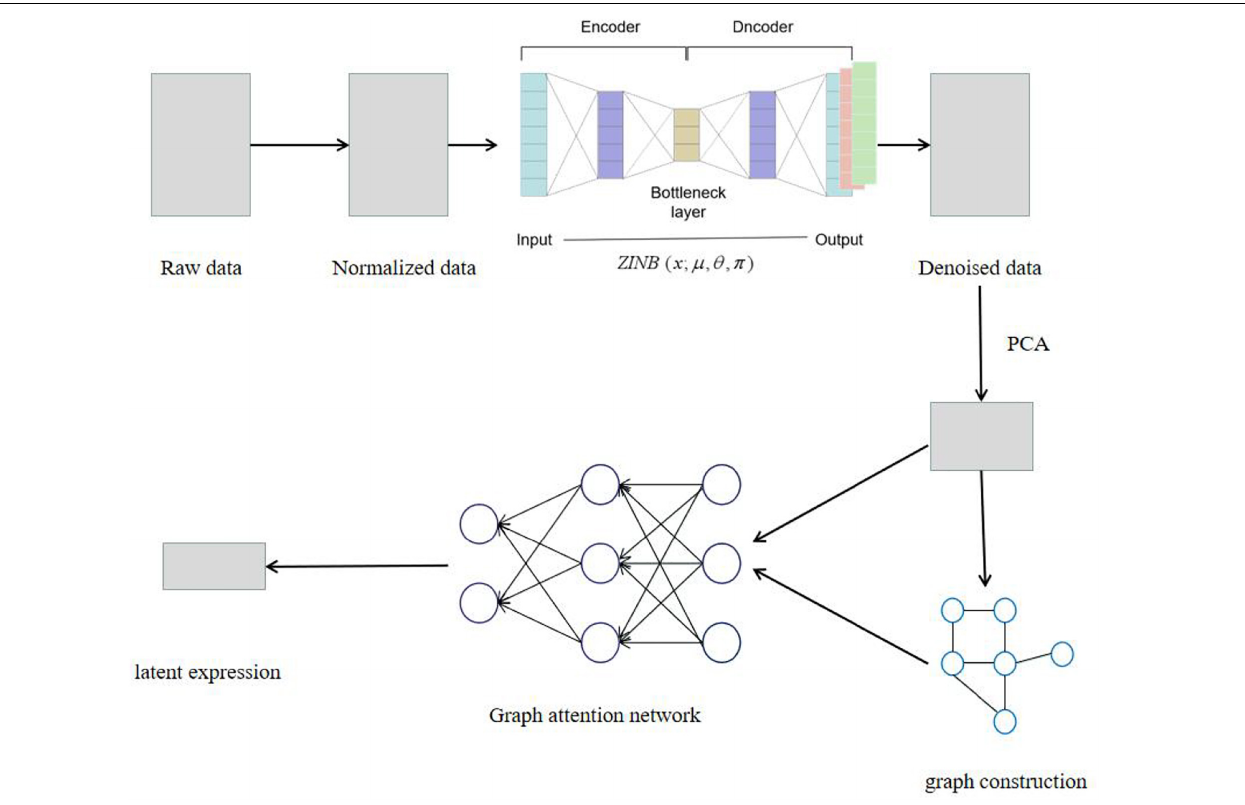
FIGURE 1 | The model architecture of SCDRHA. First, we normalize the raw data. Then, we use deep count autoencoder (DCA) to denoise the data. Ultimately, we use the compressed matrix by PCA and adjacency matrix as the input of graph autoencoder based on graph attention network (GAT) and get a low-dimensional